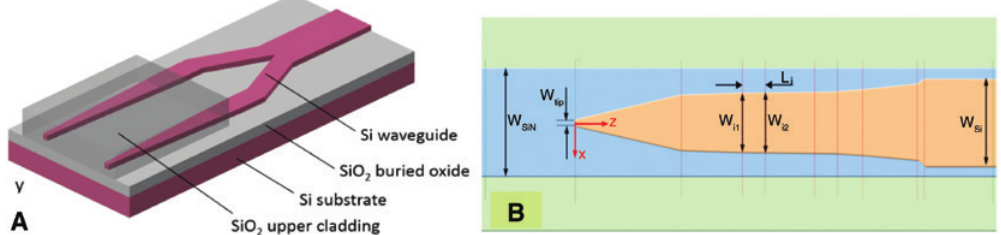
Figure 14: Waveguide tapers for multimode fiber-chip coupling. (A) Double-tip inversed taper [159]. (B) Inversed taper